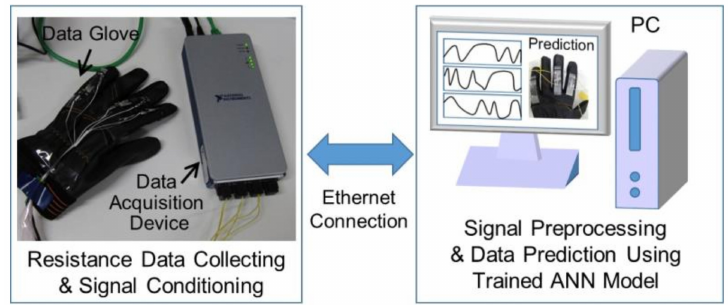
Figure 2. Configuration of the gesture prediction system using the time delay neural network (TDNN)